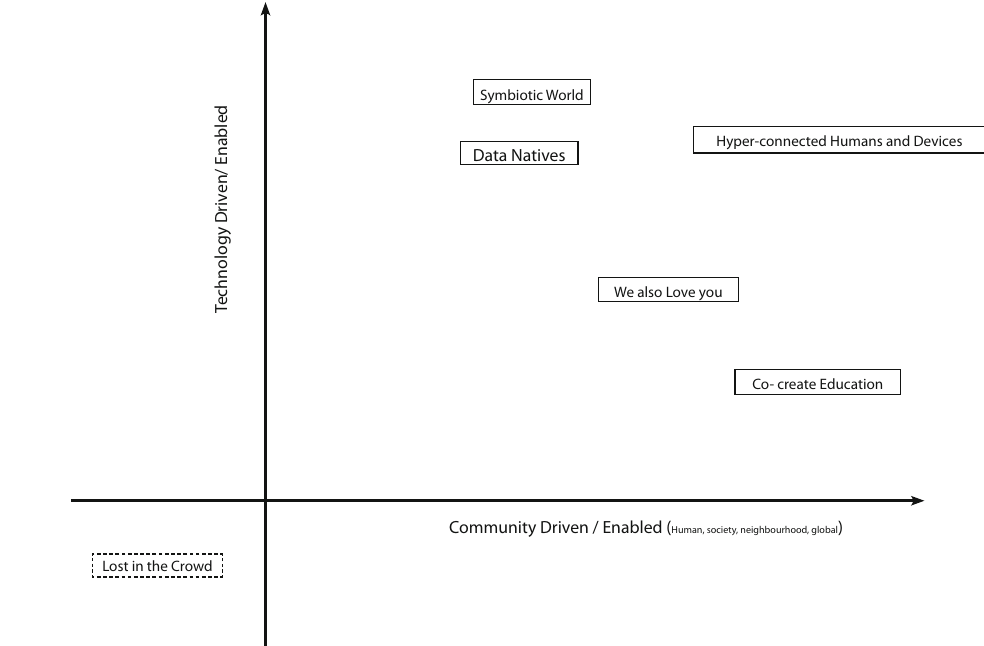
Fig. 6 Factors affecting the